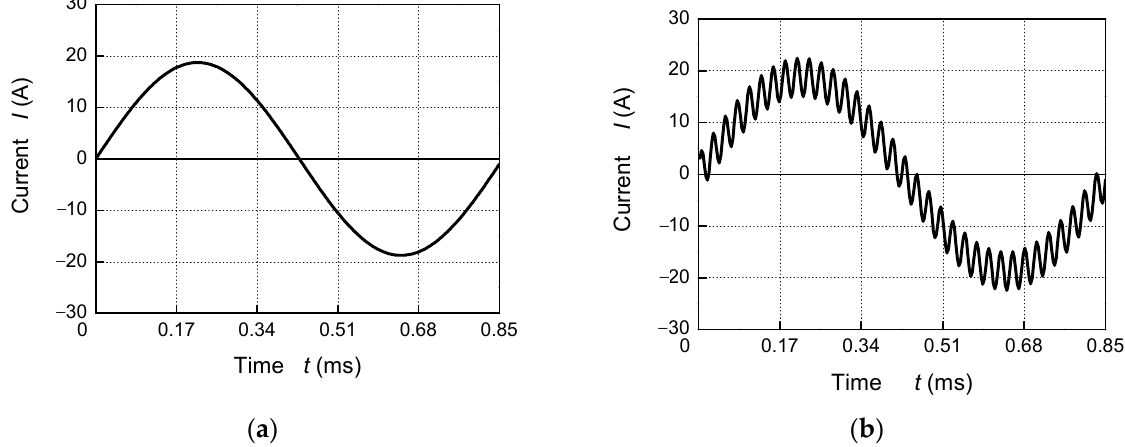
Figure 8. Current waveform superimposed with carrier harmonics: ( a ) ripple = 0%; ( b ) ripple = 20%. Panels (a) and (b) of Figure 9 show the distributions of magnetic flux density in the motors with bare and magnetic tape-wrapped rectangular windings, respectively. Unlike the magnetic flux density in the bare winding, the magnetic flux density of the winding with magnetic tape was suppressed to 0.5 T owing to induced leakage flux.